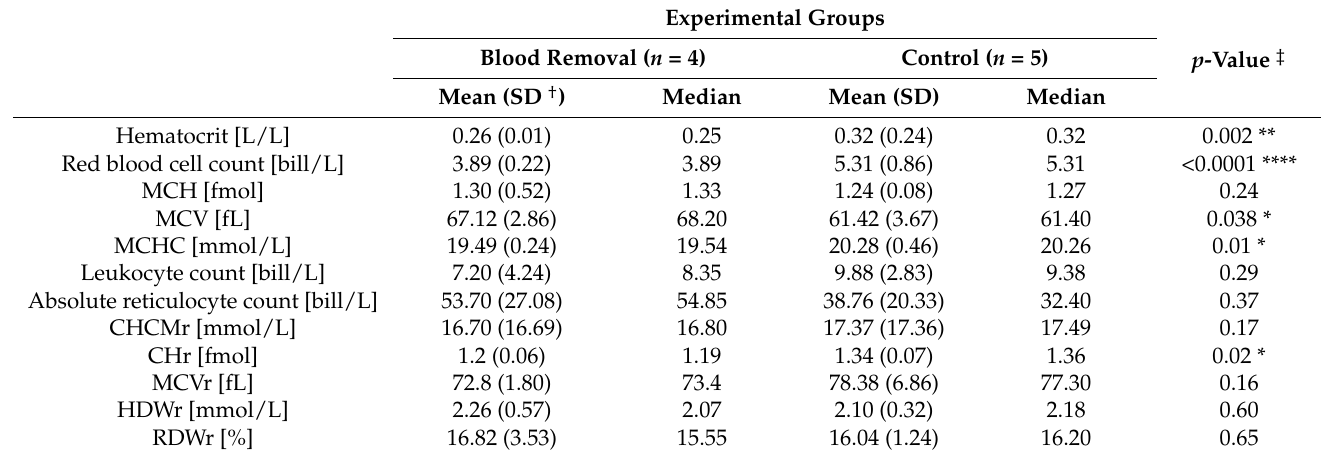
Table 4. Hematologic parameters of sows at farrowing in trial